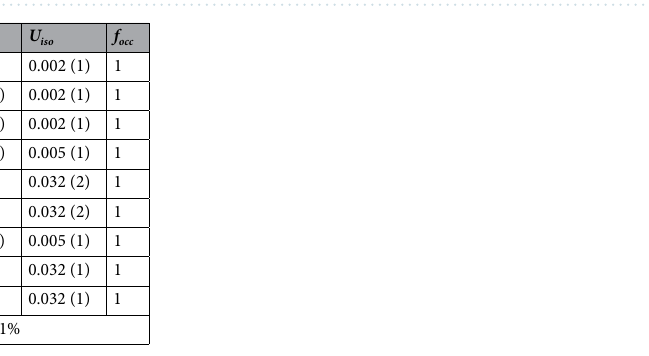
Figure 3. ( a ) Observed (crosses) calculated (black line) and difference (blue line) profiles after the Rietveld refinement from NPD data at 2 K, corresponding to orthorhombic ( Pnma ) symmetry. ( b ) View of the orthorhombic unit-cell of the corresponding crystallographic model.